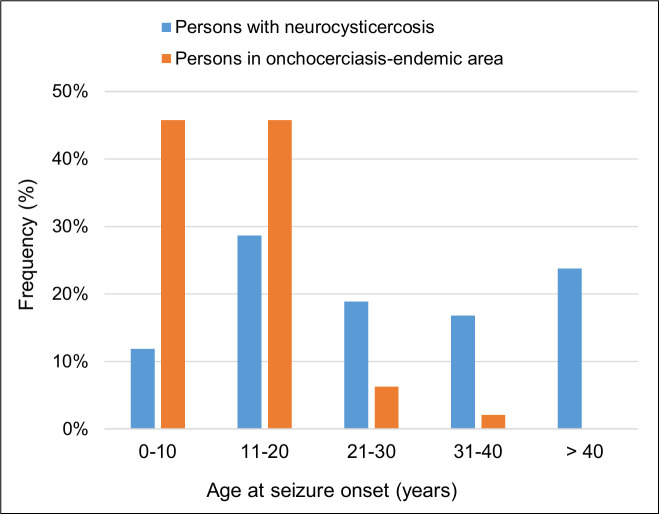
The ages at seizure onset in persons with neurocysticercosis (blue) and those in onchocerciasis-endemic areas (orange). Adapted from findings reported by Monteiro and colleagues [72] and by Lenaerts and colleagues [53].